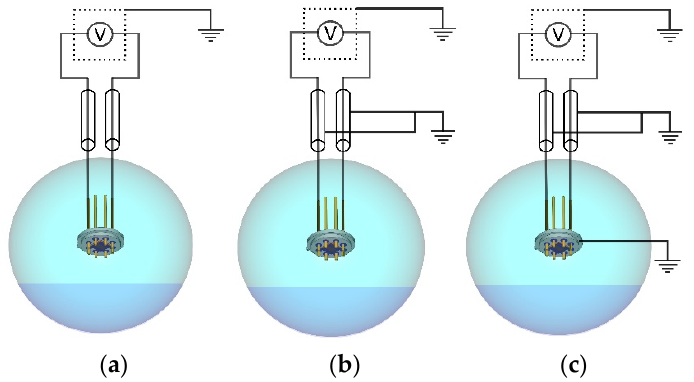
Figure 12. Measurement configurations: ( a ) voltmeter is grounded; ( b ) voltmeter and cable shields are grounded; ( c ) voltmeter, housing, and cable shields are grounded.